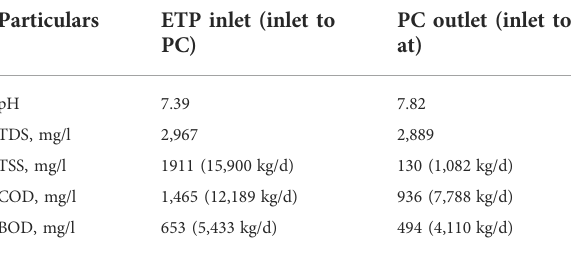
TABLE 5 Average characteristics of wastewater collected and pollution load generated at star paper mills Ltd.